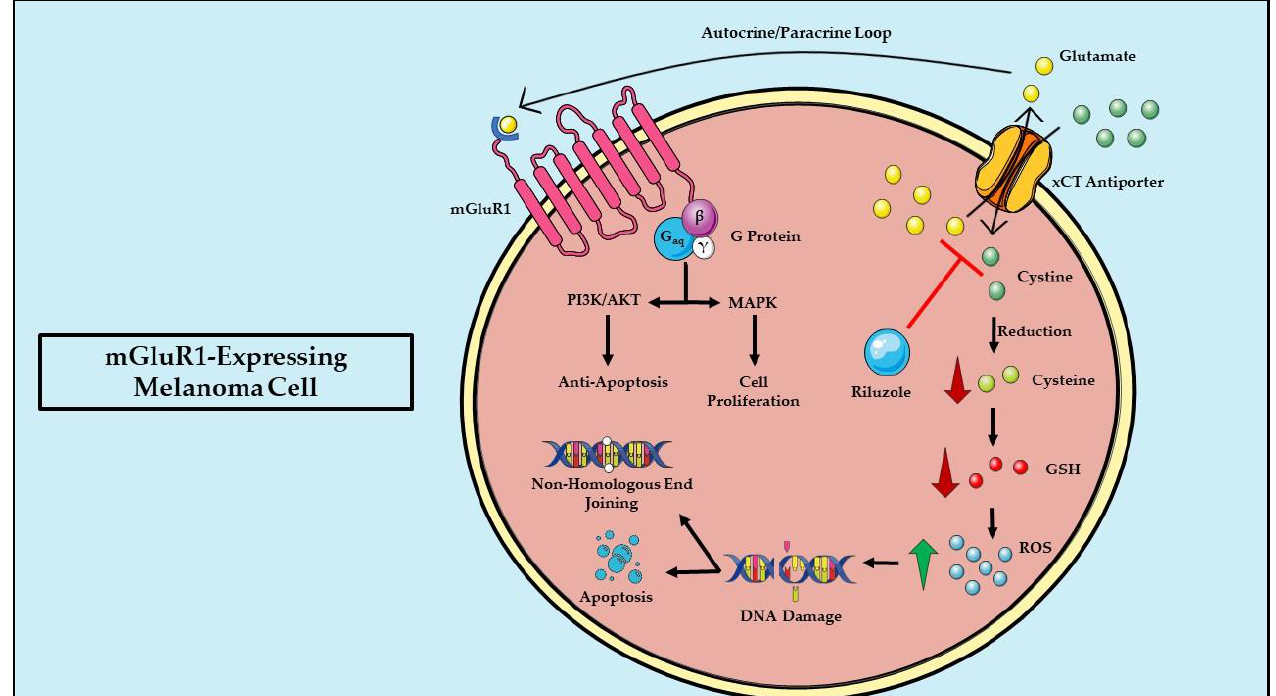
Figure 3. The proposed mechanism of action of riluzole in mGluR1-expressing melanoma cells. This illustration highlights the mechanism of cystine import, and glutamate export into cells via the xCT antiporter, as well as the proposed mechanism of action of riluzole in mGluR1-expressing melanoma cells via blockade of xCT activity. The straight black arrows indicate the cellular signaling pathways. The red arrow indicates the inhibitory activity of riluzole on the xCT antiporter. The curved black arrows indicate transport of molecules inside and outside of the cell. Abbreviations: glutathione (GSH) and reactive oxygen species (ROS). Parts of the figure were created using pictures from Servier Medical Art. Servier Medical Art by Servier is licensed under a Creative Commons Attribution 3.0 Unported License (https://creativecommons.org/licenses/by/3.0/, accessed on 15 June 2022).